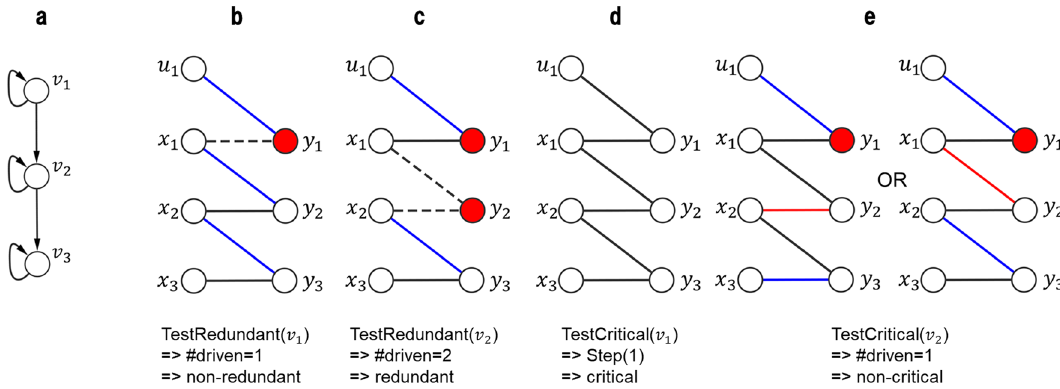
Figure 8. Illustration of the novel algorithm for critical/redundant driven nodes identification. ( a ) Original network. ( b , c ) Example of TestRedundant( v i ) procedure. Dashed edges are those deleted at Step (2) of TestRedundant( v i ). ( d , e ) Example of TestCritical( v i ) procedure. Red edges are those that are forced to put in M at Step (4) of TestCritical( v i ). Red nodes indicate driven nodes. Blue edges denote matching